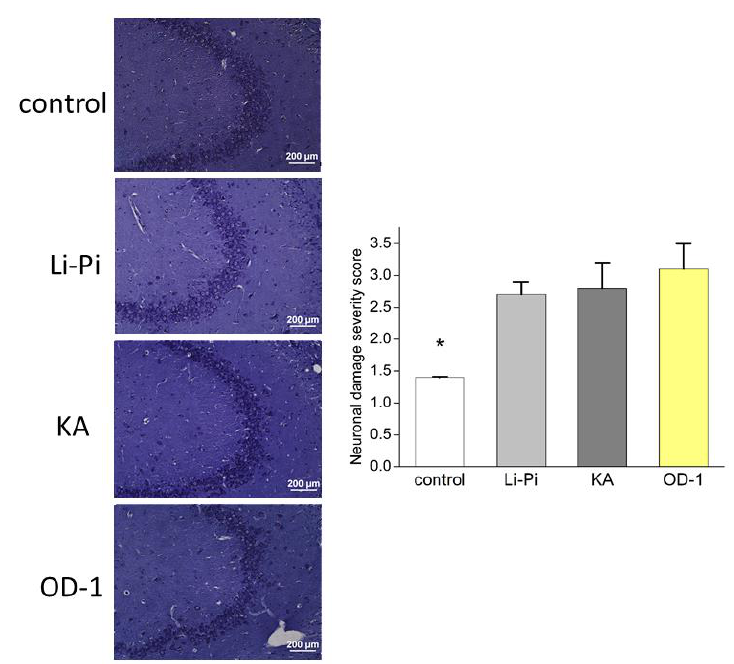
Figure 6. There were similar amounts of cresyl violet stained hippocampal neurons in the Li-Pi, KA, and OD-1 models. Scale bar = 200 μm. The semiquantitative neuronal damage scores were similar across the three groups ( p = 0.20) although the OD-1 group had a slightly higher overall score. The naïve control (1.4 ± 0.01) showed significantly less damage than the other three groups (* p < 0.05). Data were analyzed using an ANOVA Kruskal–Wallis H test followed by Dunn’s multiple comparison tests ( n = 7 in each group). Int. J. Mol. Sci. 2020 , 21 , x FOR PEER REVIEW